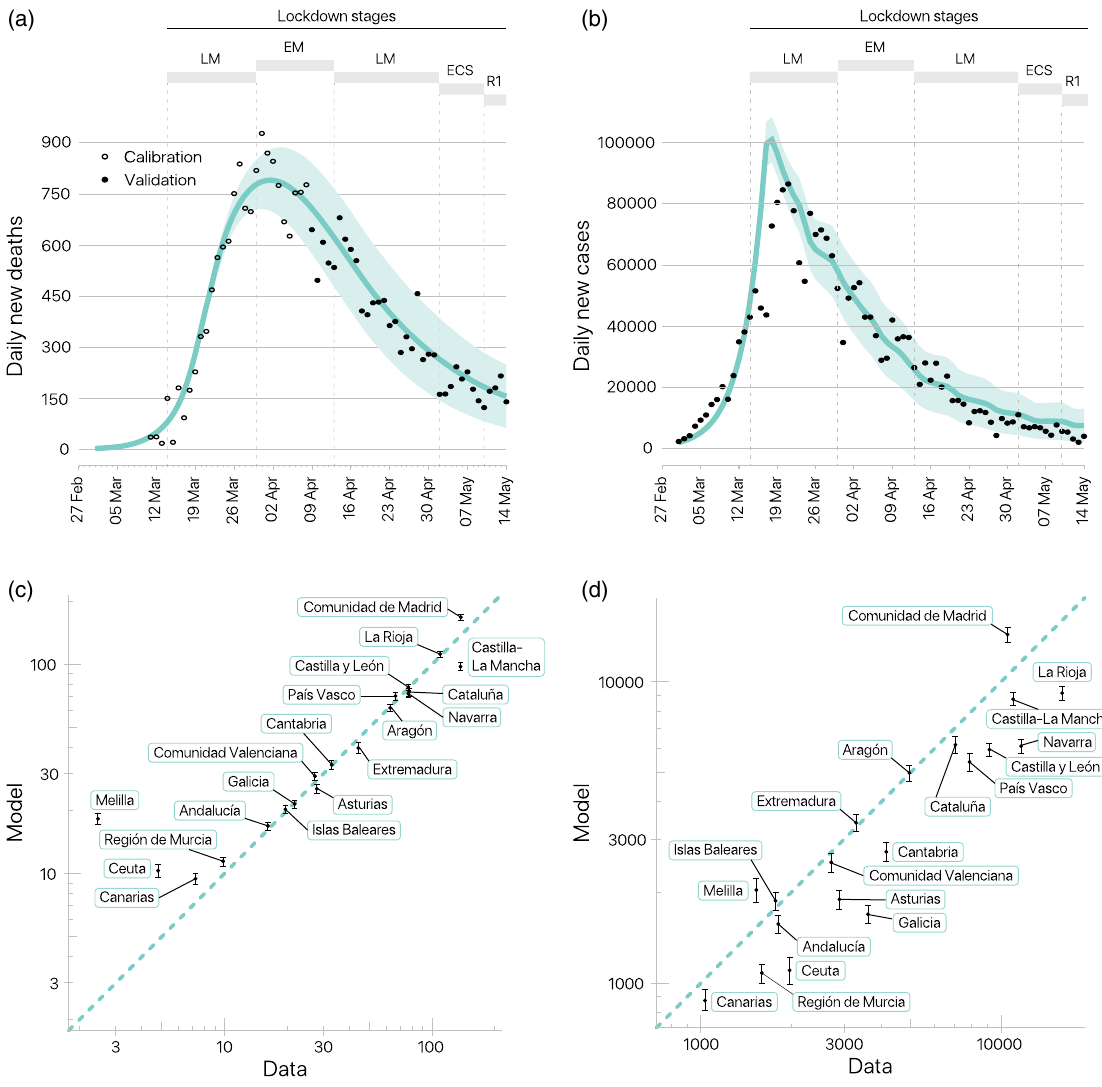
FIG. 2. Model validation and spatiotemporal propagation of COVID-19 across Spain. Top: Solid lines show model predictions for the daily fatalities (a) and the daily number of new symptomatic individuals (b), whereas dots correspond to real data. The shadowed areas represent the 95% prediction interval. Bottom: Correlation between the accumulated number of deaths ( r ¼ 0 . 98 ) (c) and accumulated number of reported cases ( r ¼ 0 . 90 ) (d) per 100 000 inhabitants observed by May 15 and those predicted by the model. The plot shows this correlation at the level of Comunidades Autónomas of Spain. Error bars cover the 95% prediction